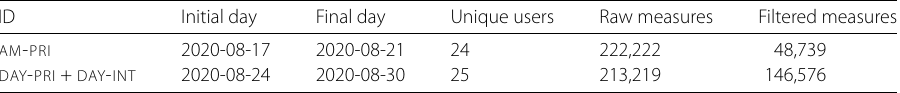
Table 6 Statistics of the raw data sets, including the number of measures before and after the pre-processing step